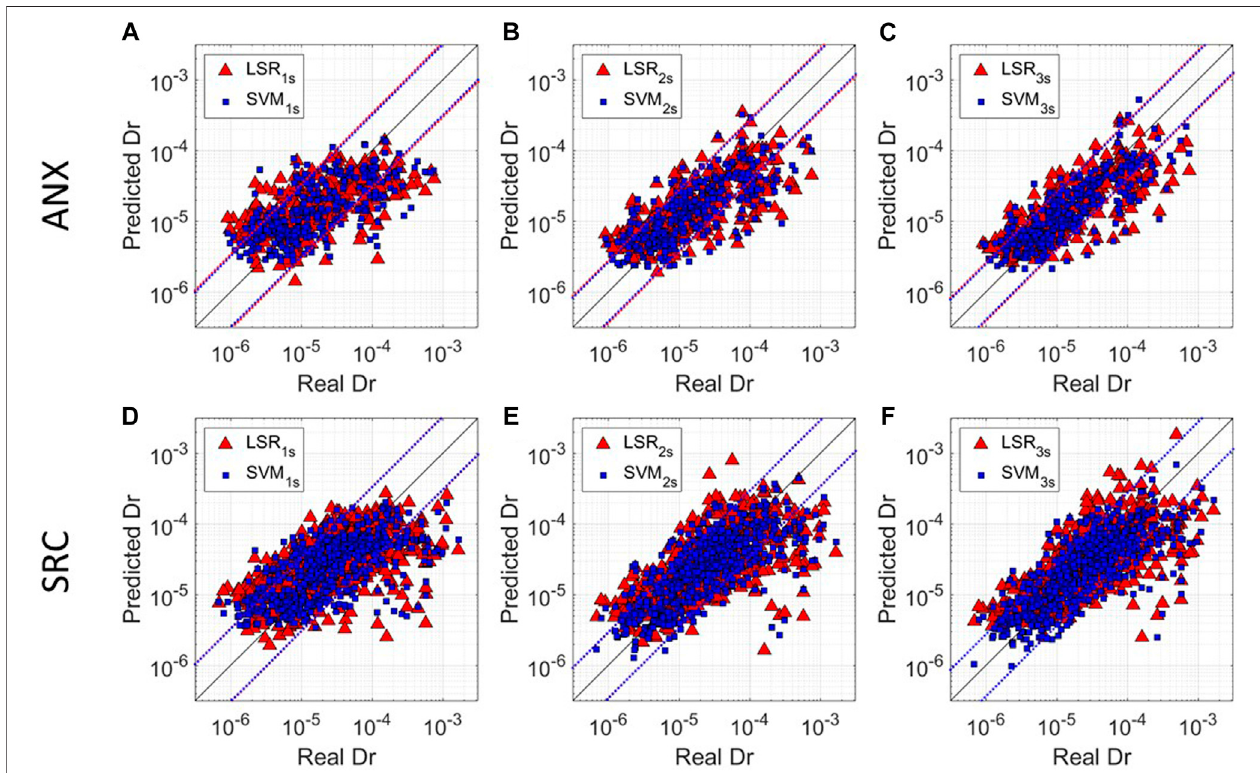
FIGURE3| PredictedDr.vs.RealDr.forthreedifferentwindowsforANXdataset (A – C) andforSRCdataset (D – F) .Redtrianglesrefertothepredictionmadeleast squareregressionusingcombined LSRforbothdatasetsmeasuredatthereferencewindow.BluesquaresrefertothepredictionsoftheSVMregressoratthereference window. The black line Real Dr. (cid:1) Predicted Dr. reference line. The dotted lines represent ± σ train con fi dence level for LSR (red) and ML (blue) models.